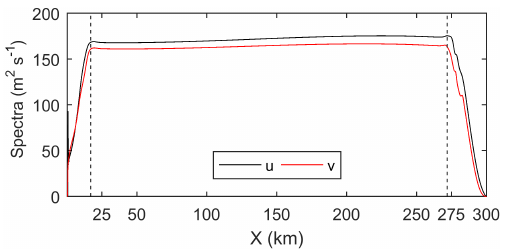
Figure 5. Spatial variation of depth-mean near-inertial spectra of velocities for the homogeneous case.